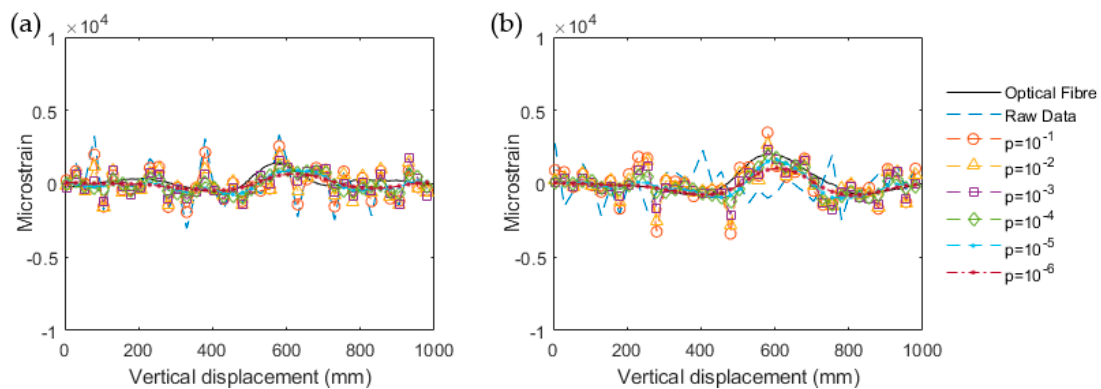
Figure 7. OOP deformation test Step 1: Strain along the vertical line ( a ) at 800 mm and ( b ) at 1000 mm for di ff erent p parameters, no filter, and optical fibre. Remote Sens. 2020 , 12 , x FOR PEER REVIEW